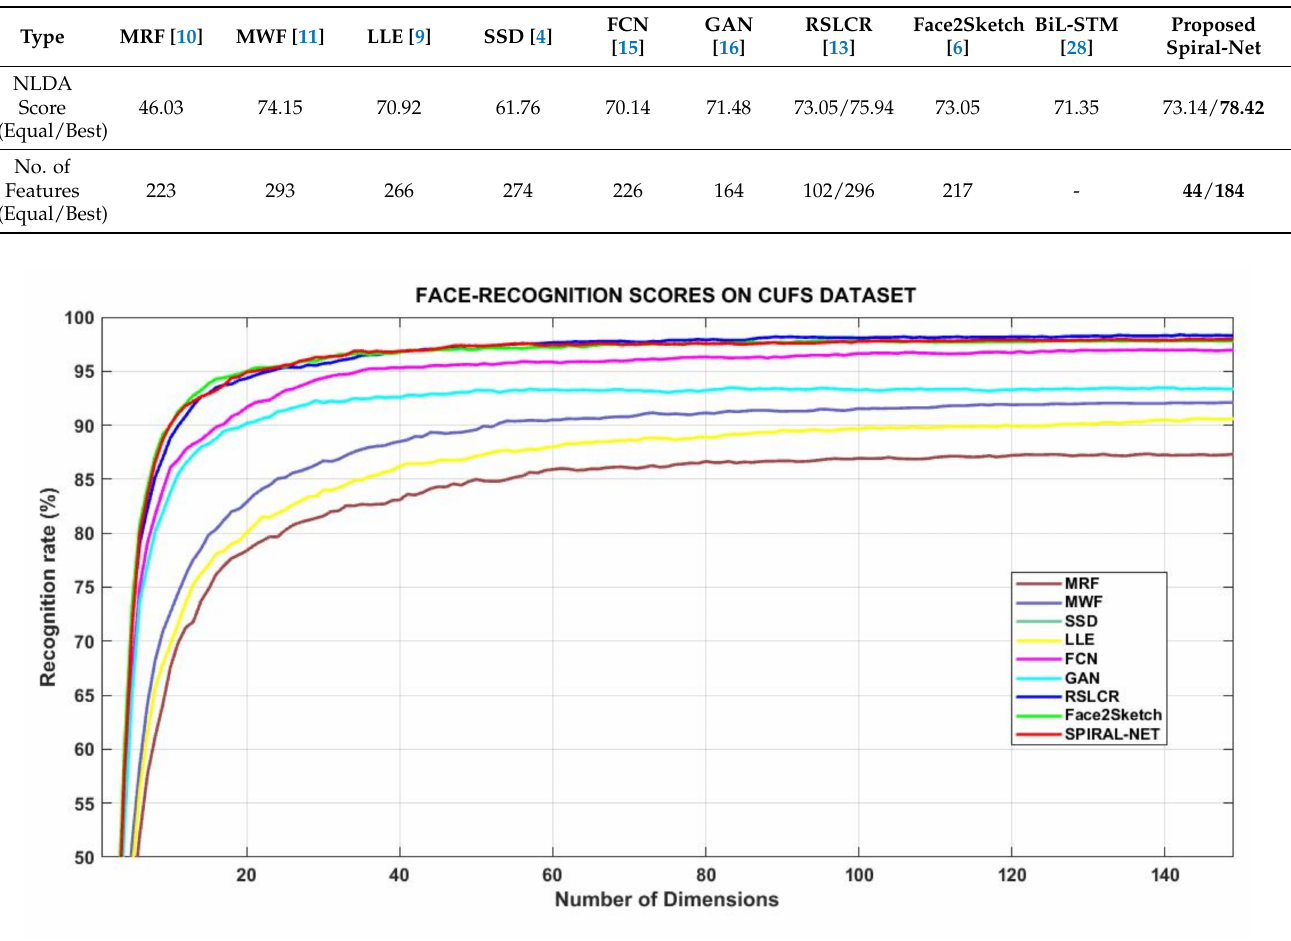
Table 7. Comparison of Face Recognition Scores for CUFSF.